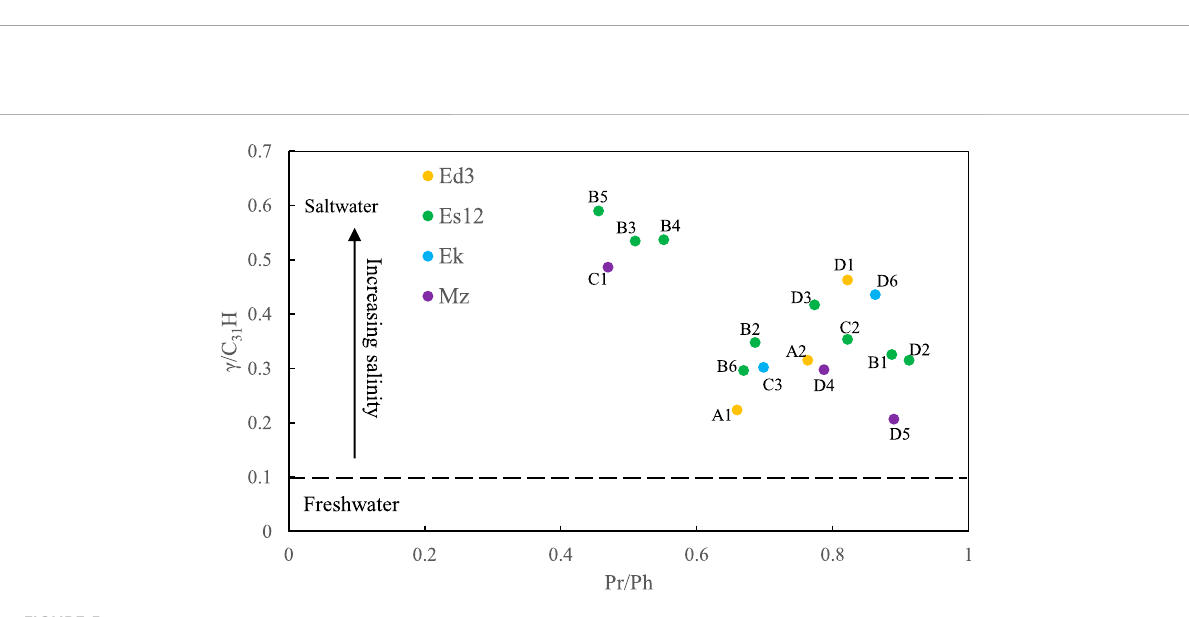
FIGURE 4 Comparison of maturity of crude oil and source rock in Qinnan